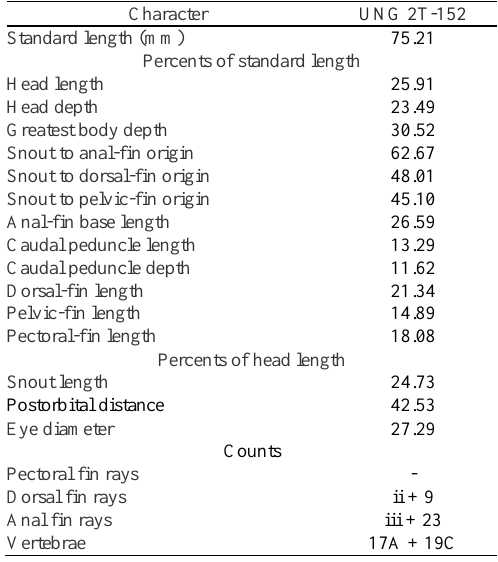
Table 1. Morphometric and meristic data of † Bryconetes enigmaticus holotype (UFRGS